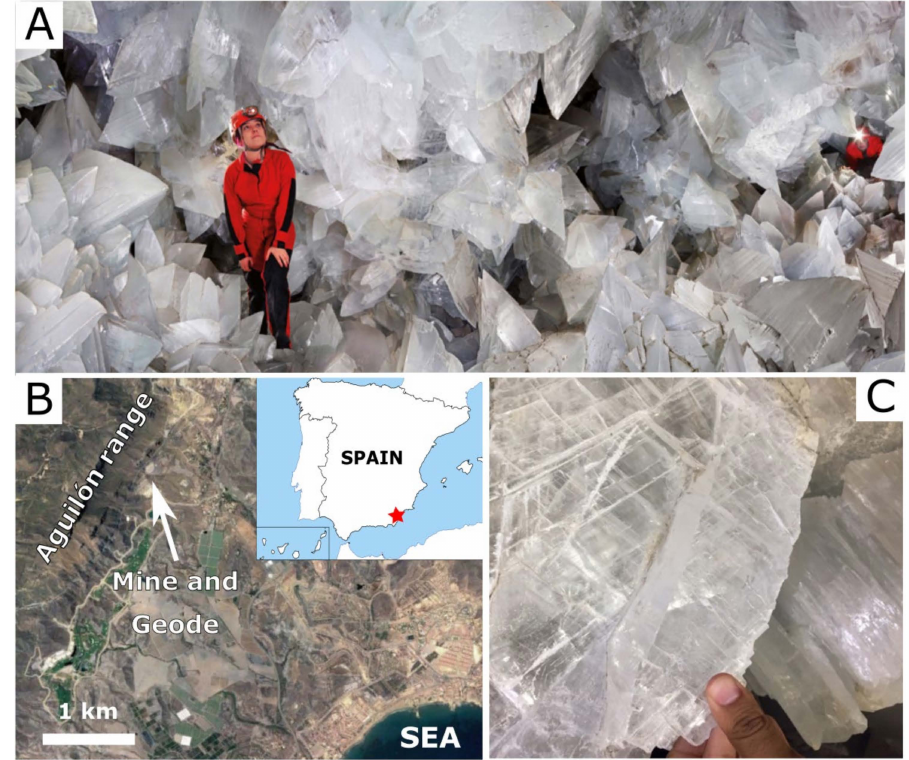
Figure 1. ( A , C ) Gypsum crystals of the Giant Geode of Pulp í ; ( B ) location of the Mina Rica mine where the Geode is located (Google Earth). Photos: V í ctor